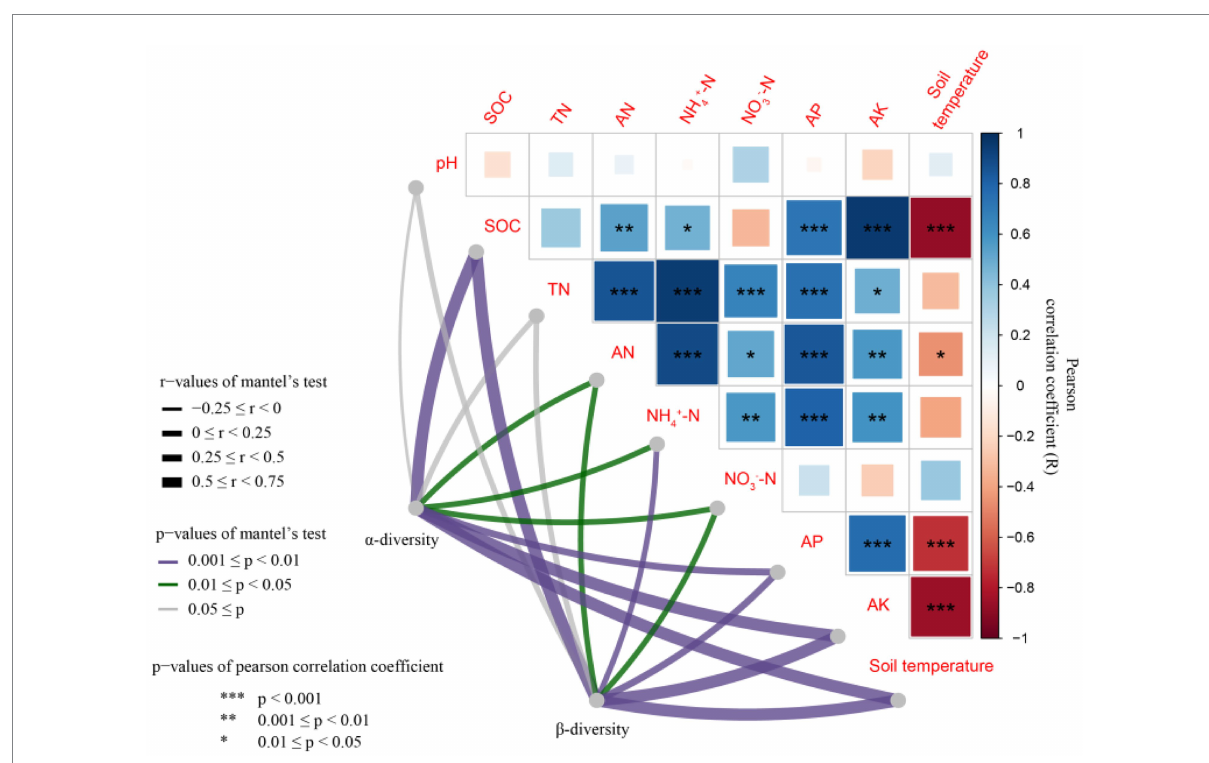
FIGURE 6 Relationship between bacterial α -diversity and β -diversity and soil environmental factors. SOC, Soil organic C; TN, Total N; AN, Available N; NH 4+ -N, Ammonium N; NO 3 − -N, Nitrate N; AP, Available phosphorus; AK, Available